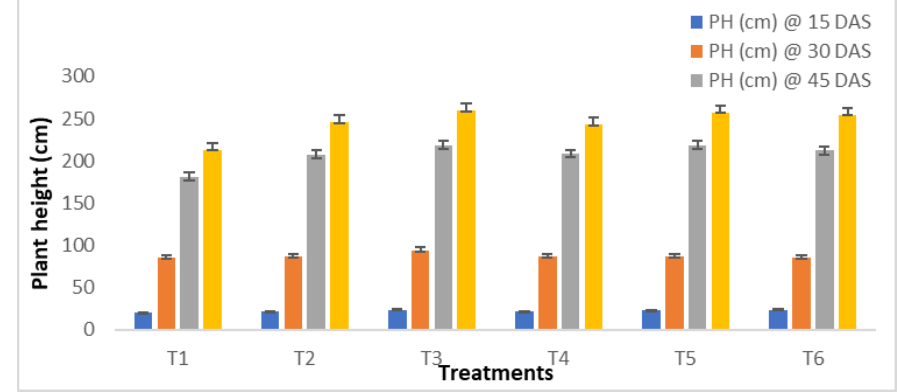
Figure 2. Effects of NPK consortia biofertilizer and chemical fertilizers on mean of plant height at different growth stages; PH = Plant height, DAS = Days after Sowing